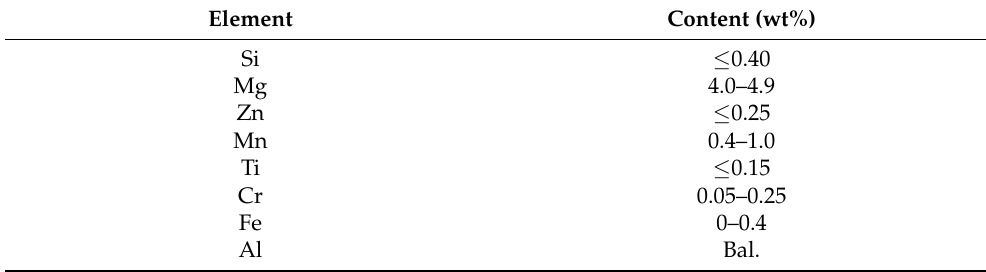
Table 1. Chemical composition of